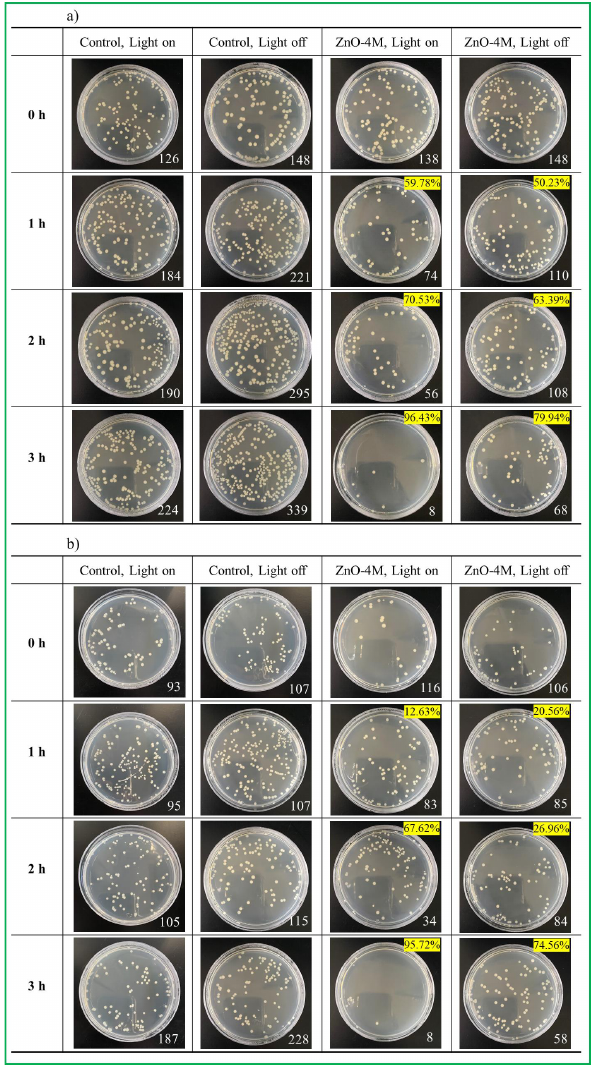
Figure 5. Sterilization capacity of ZnO− 4M catalyst against ( a ) S. aureus ; and ( b ) E. coli .